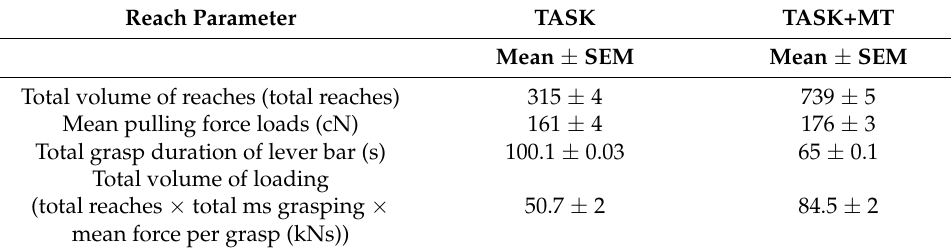
Table 3. Estimated total volume of high-repetition, high-force loading across 12